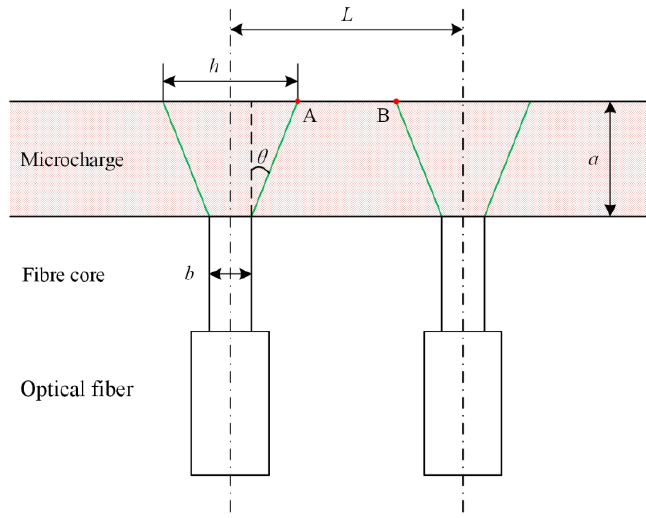
Figure 3. Diagrammatic sketch of the probes’ arrangement.